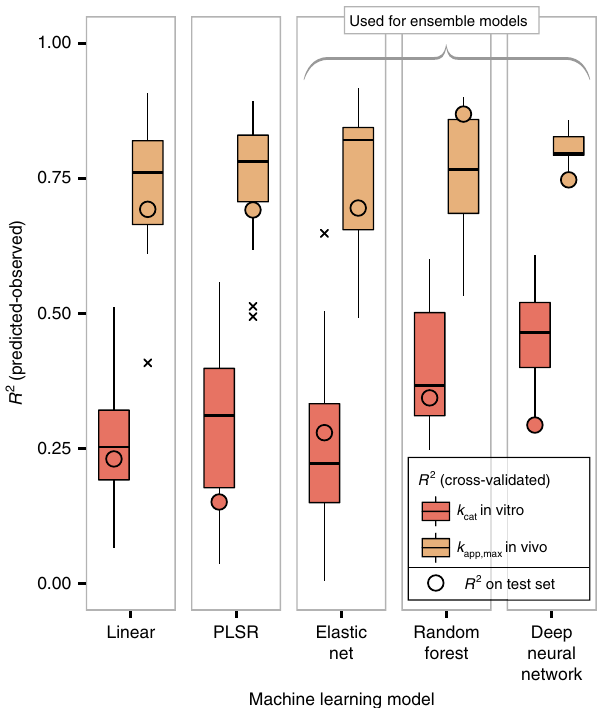
Fig. 2 Machine learning model performances for k app,max and k cat in vitro. Center lines show the median R 2 across fi ve times repeated fi ve-fold cross- validation (25 validations), except for the deep learning case, where the median for a single round of fi ve-fold cross-validation ( fi ve validations) is shown. Box limits represent the 1st and 3rd quartiles, whiskers extend to values that lie within the 1.5x interquartile range, and the remaining points are shown as outliers (marked x). Circles show R 2 for a test set consisting of 20% of the available samples that were not used for hyperparameter optimization. This resulted in a training set of 172 observations of k cat in vitro and 106 observations of k app,max . For the test set, 43 and 27 observations were used for k cat in vitro and k app,max , respectively.